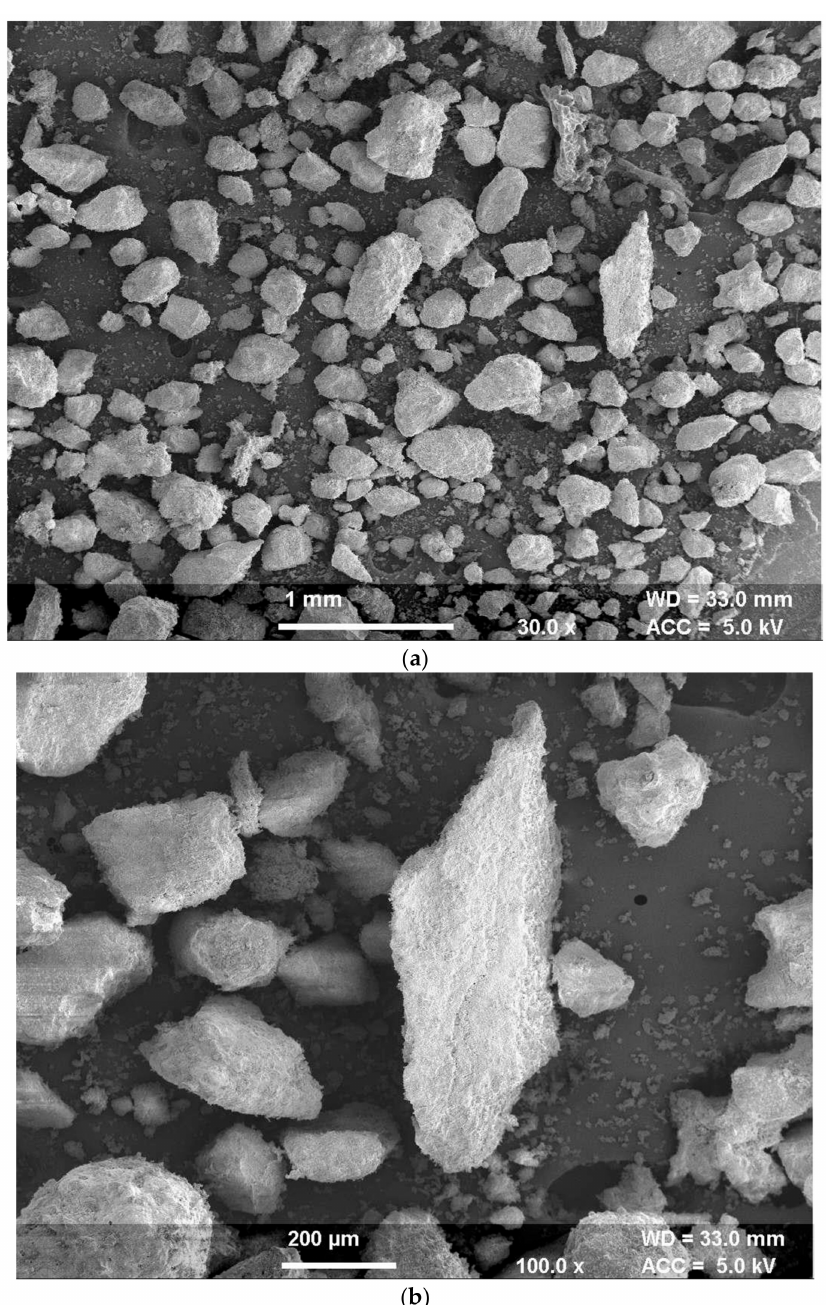
Figure 5. ( a ): SEM micrographs for brick kiln dust at magnification 30 × ; ( b ): SEM micrographs for brick kiln dust at magnification 100 ×